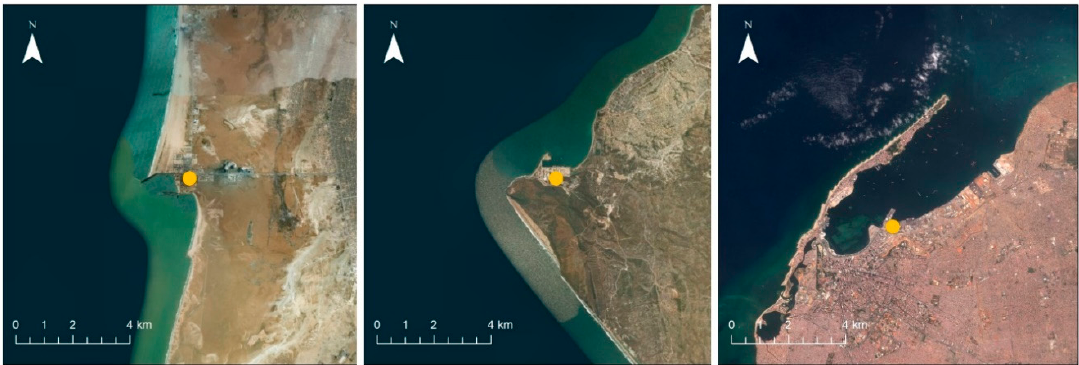
Figure 7. Examples of ports with different sheltering settings. Left—open sandy coast (Port of Nouakchott, Mauritania); middle—headland-bay coast (Port of Amboim, Angola); right—coast behind natural barrier (Port of Luanda, Angola).